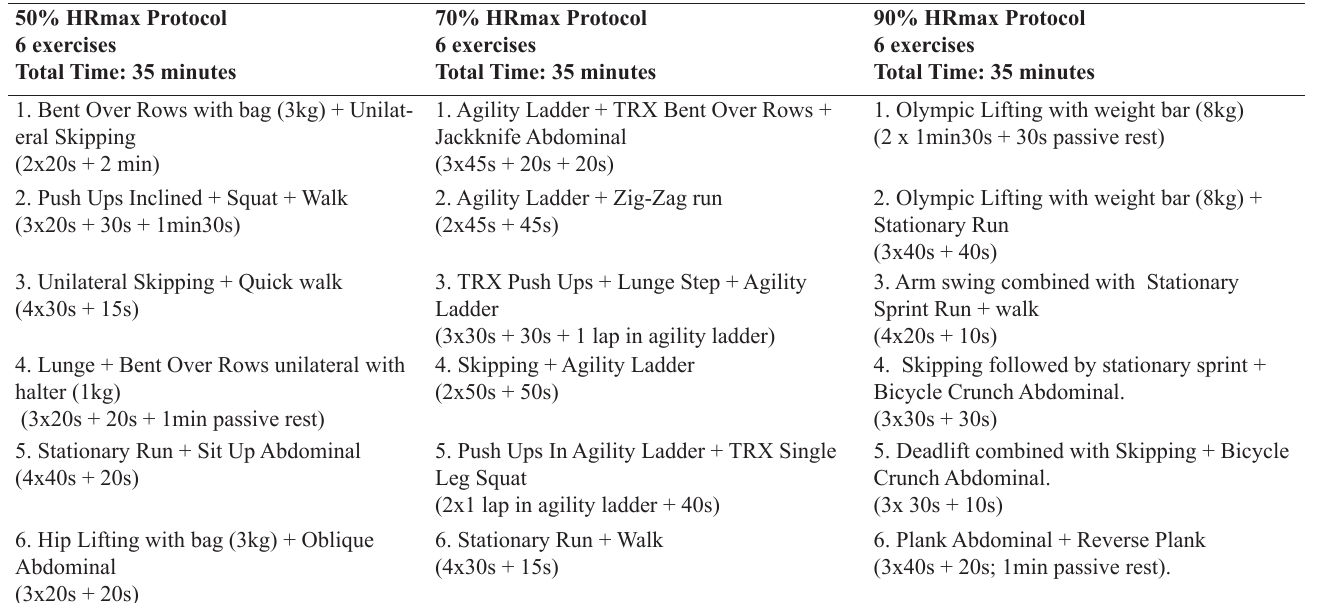
Table 1. Exercises performed during the compounding circuit training sessions at different intensities. 50% HRmax